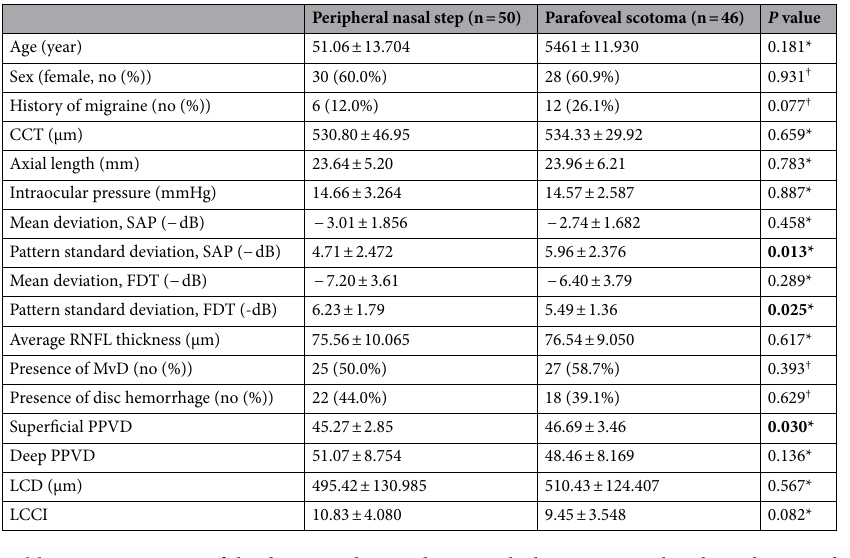
Table 2. Comparison of the demographics and test results between peripheral nasal step and parafoveal scotoma. Mean values are presented with standard deviations. No number, CCT central corneal thickness, *Student’s t-test. † Chi-squared test.